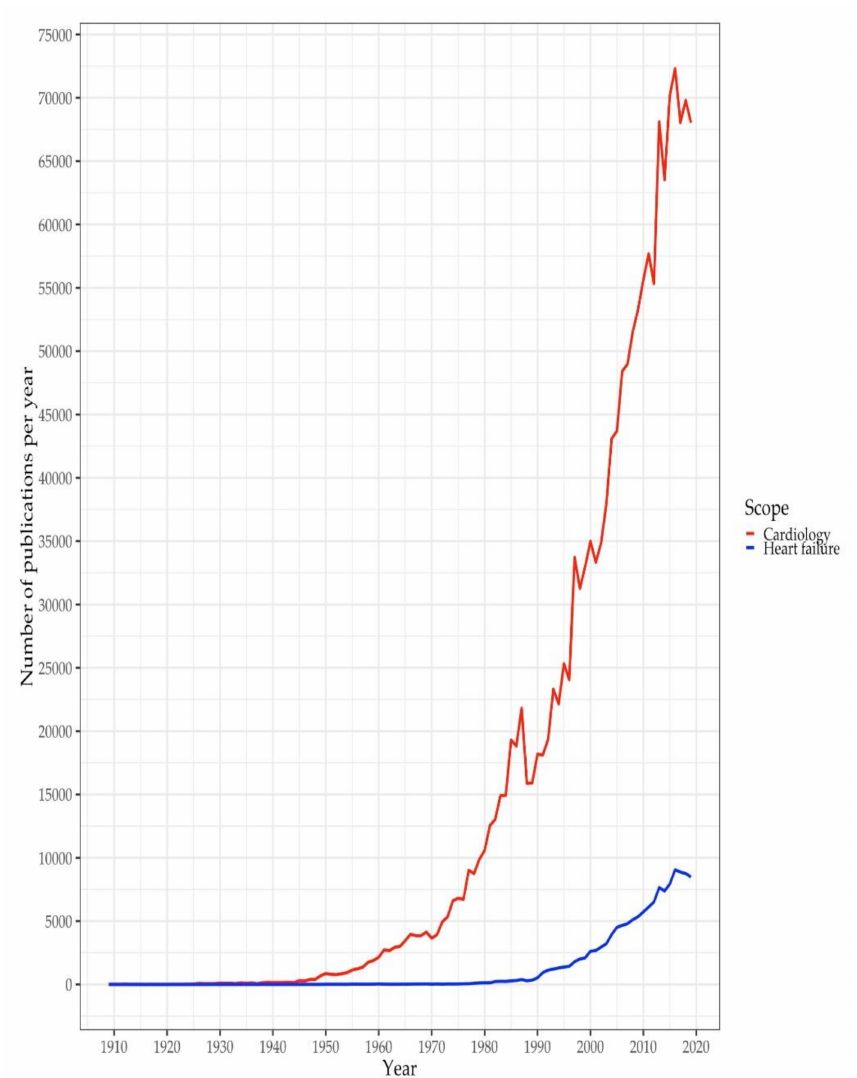
Figure 3. Publication output in cardiology and heart failure between 1910 and 2019 (based on a dataset compiled from Web of Science